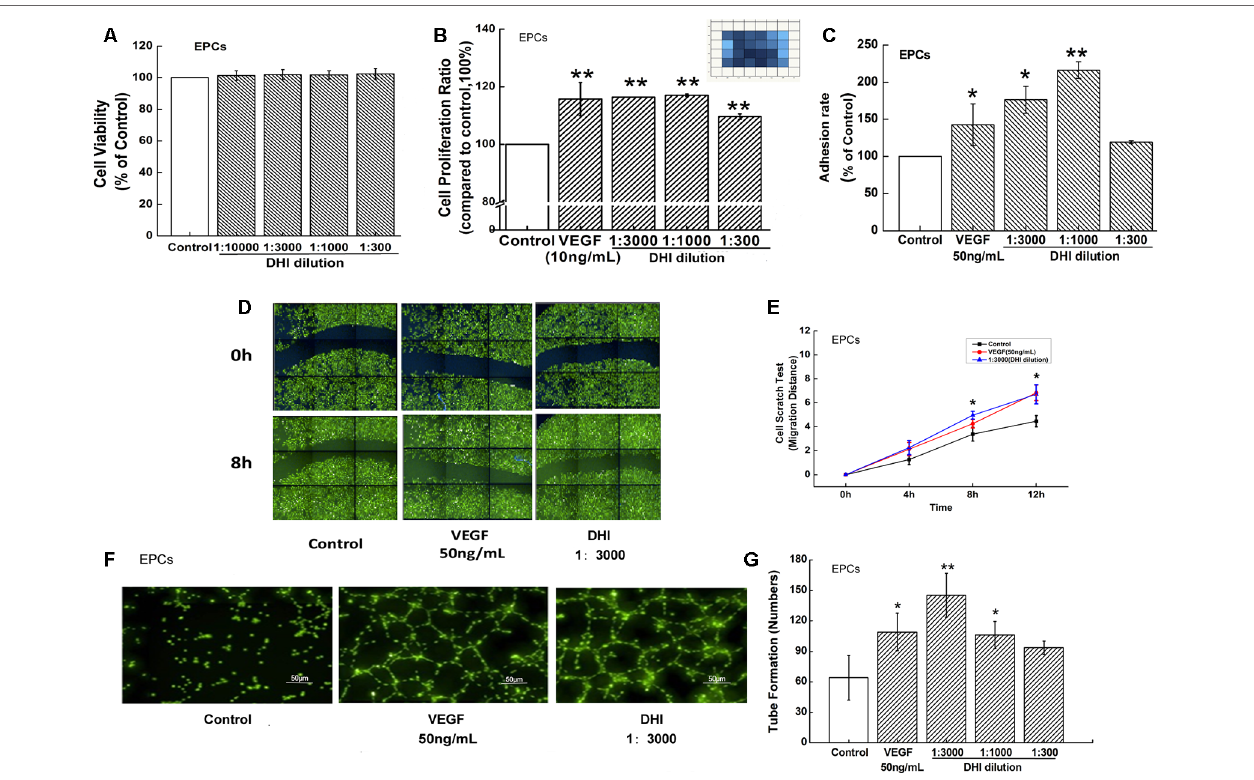
FIGURE 4 | DHI improved EPCs function. (A) EPCs viability was determined by Cell Counting Kit-8 assay under different concentrations of DHI, none dilution caused any significant viability changes. (B) Different concentrations of DHI significantly increased EPCs proliferation after 48-h cultivation. (C) VEGF (50 ng/ml) and lower concentrations of DHI (3000- and 1000-fold dilution) increased the adhesion ability significantly whereas the highest concentration of DHI (300-fold dilution) had no effect on EPCs adhesion ability. (D) Representative images of the wound healing assay in EPCs. (E) Quantitative analysis of the migration distance, VEGF or DHI (3000-fold dilution) promoted the cell migration after 8 h. (F) Microscopic image showing tube formation of EPCs. (G) After incubating for 12 h with DHI, difference dilution folds of DHI promoted angiogenesis in EPCs. Data represent the mean ± SD. *P < 0.05, **P < 0.01, compared with the control